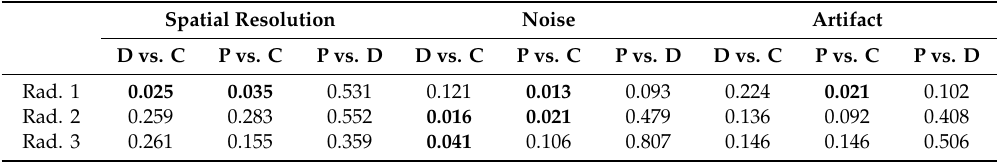
Figure 7. Mean of the score differences of in vivo videos ( N = 22) between DWI and CF ( d D vs. C ), between PWI and CF ( d P vs. C ), and between PWI and DWI ( d P vs. D ). The asterisk indicates a significant difference ( p < 0.05). DWI and PWI show higher scores on average than those of CF in all cases. PWI and DWI (P vs. D) show similar performance with no significant differences. Table 4. P-values of the rank-sum test between each pair of CF, DWI, and PWI in the in vivo video evaluation ( N = 22) (all P-values less than 0.05 (i.e., statistically significant differences) are shown in bold).